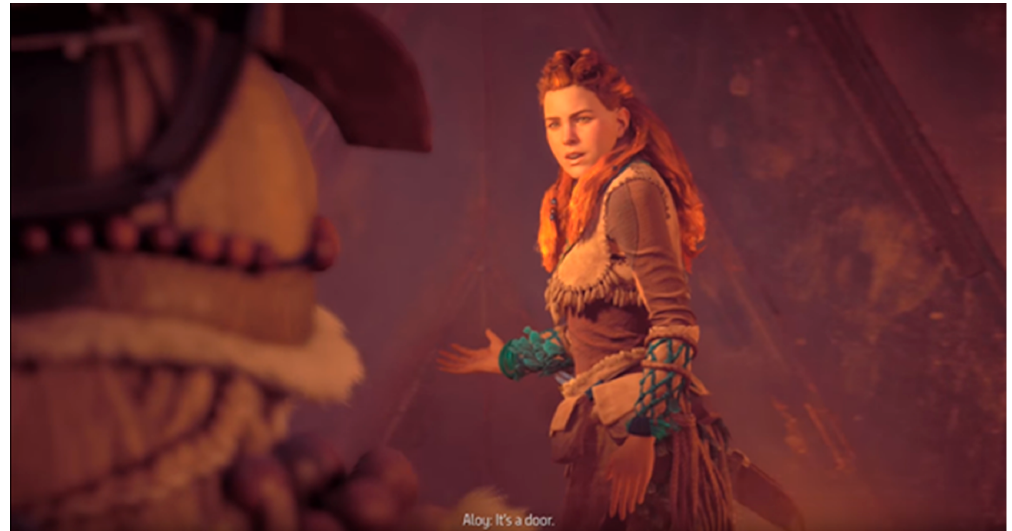
Figure 8. Aloy tries to explain to a matriarch that All-Mother is actually a door.